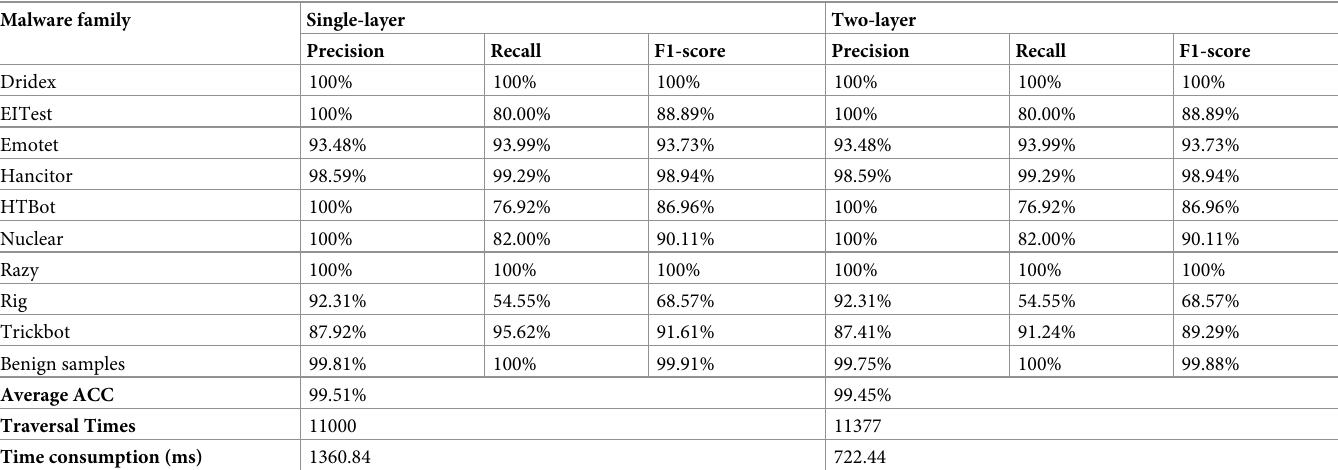
Table 8. Comparison of the two